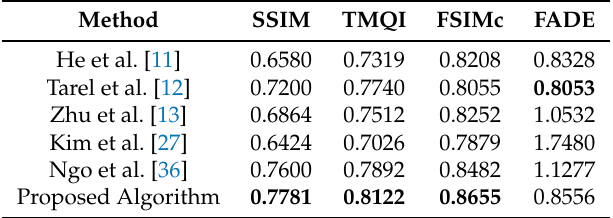
Table 7. Average SSIM, TMQI, FSIMc, and FADE scores on I-HAZE dataset.